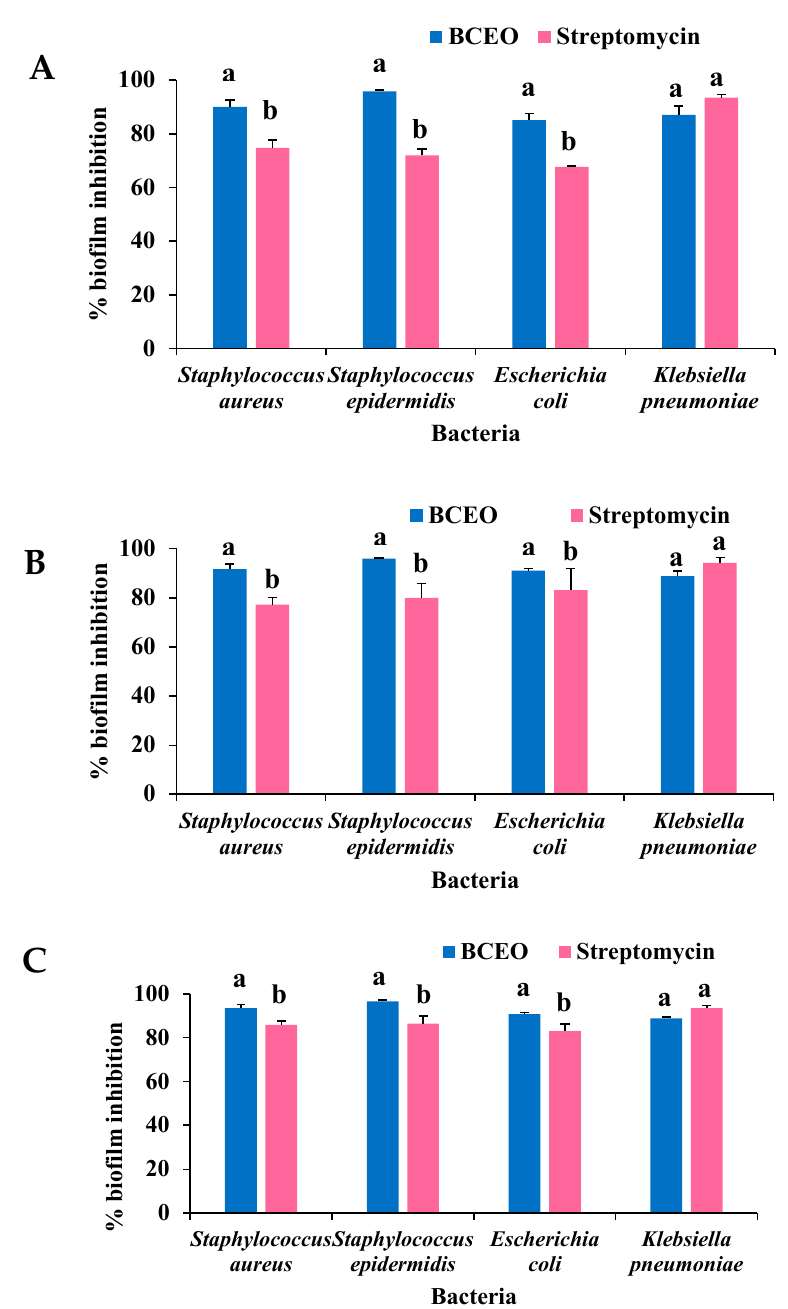
Figure 2. Effects of BCEO and streptomycin on the inhibition of biofilm formation of S. aureus , S. epidermidis , E. coli, and K. pneumoniae , expressed as biofilm inhibition (%) at ( A ) 0.5 × MIC, ( B ) 1.0 × MIC, and ( C ) 2.0 × MIC. Bars represent mean ± SD of triplicates in three independent experiments. Error bars are standard deviations. Within the same bacteria, bars with different letters (a, b) differ significantly ( p < 0.05). BCEO, B. citriodora essential oil.